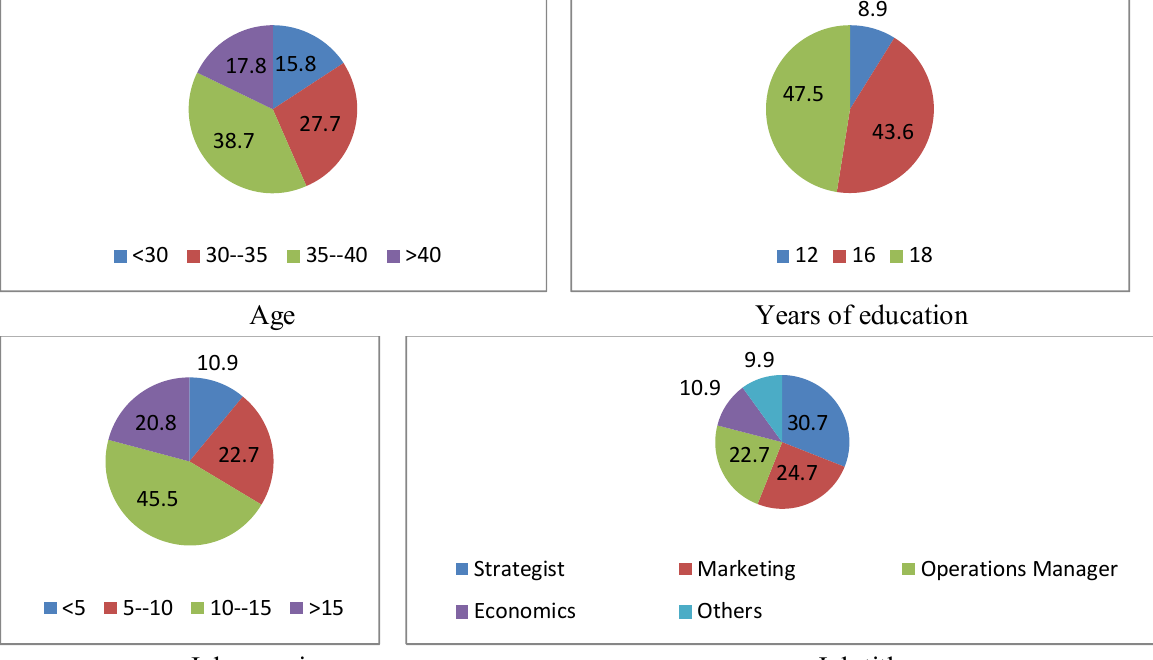
Fig. 2. Personal characteristics of the